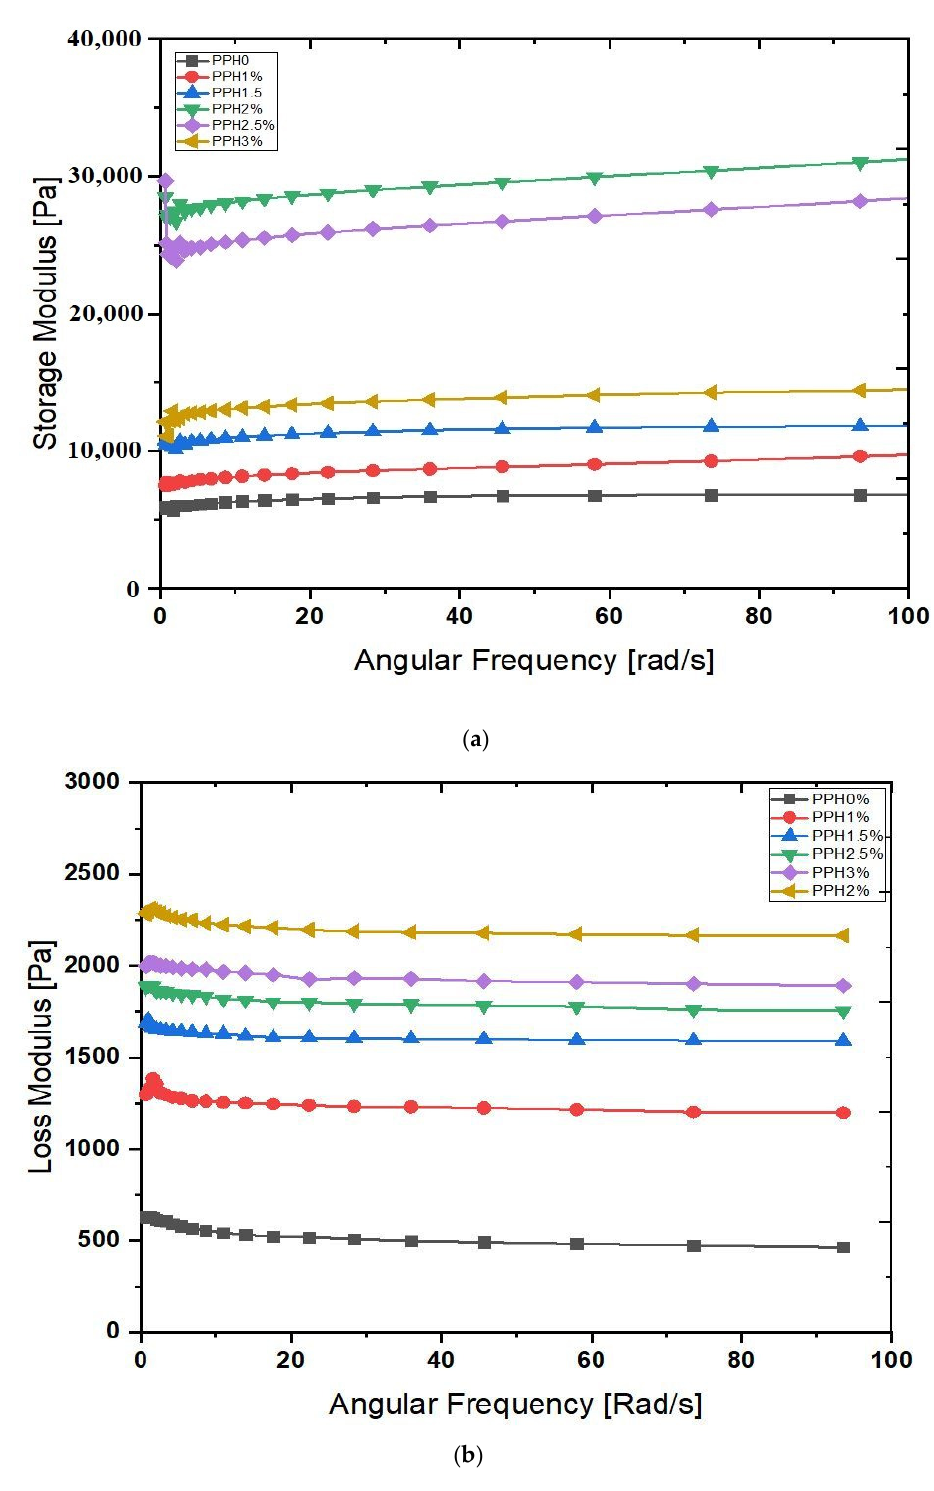
Figure 6 . Rheological properties of PVA/PVP/HNr Composite hydrogel. ( a ) StorageModulus, ( b ) Loss modulus .